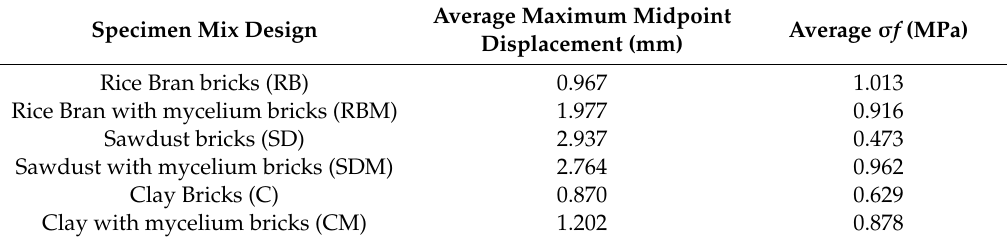
Table 2. Average values of the total displacement and flexural strength . Specimen Mix Design